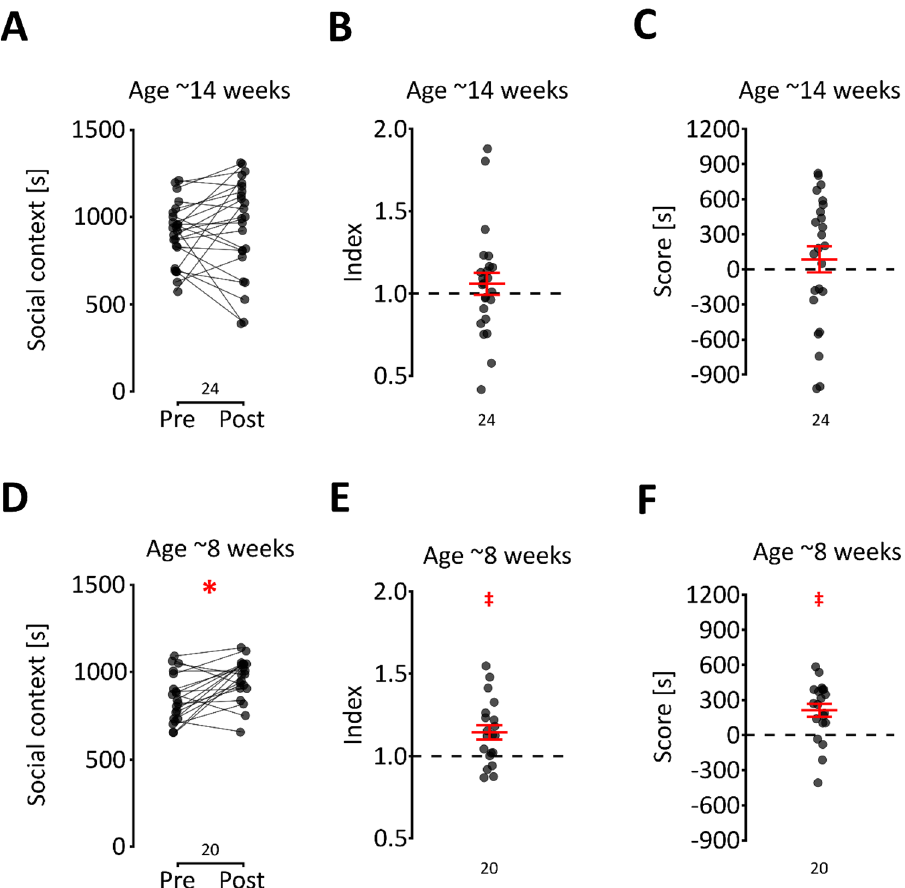
Figure 3. The effect of the time length on conditioning on social reward. ( A–C ) The change in time spent in the first context between pre- and post-test, the index and the score, respectively, for 8-week-old mice after the 2-day conditioning procedure. The mean and s.e.m. values are shown in red in ( B,C ). ( D–F ) The change in time spent in the first context between pre- and post-test, the index and the score, respectively, for 8-week-old mice after the 2-day conditioning procedure. The mean and s.e.m. values are shown in red in ( E,F ). Significant effects are shown with a red “*” or “‡” (p < 0.05, two- or one-sample t test,